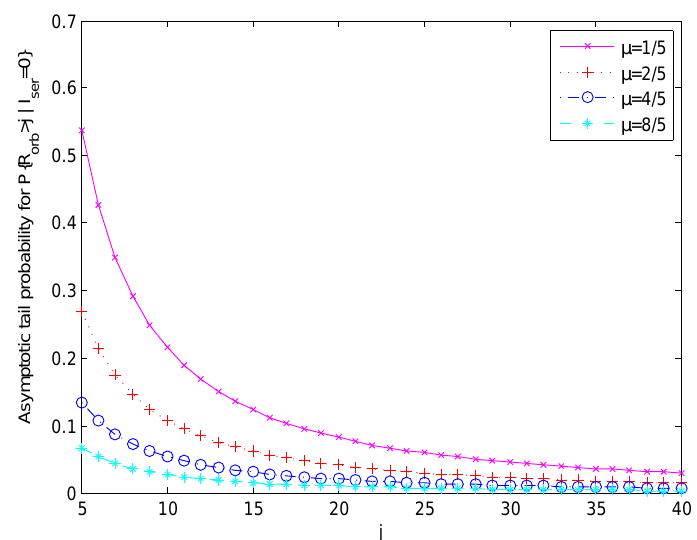
Figure 3. Impact of the retrial rate µ on the asymptotic tail P { R orb > j | I ser = 0 }